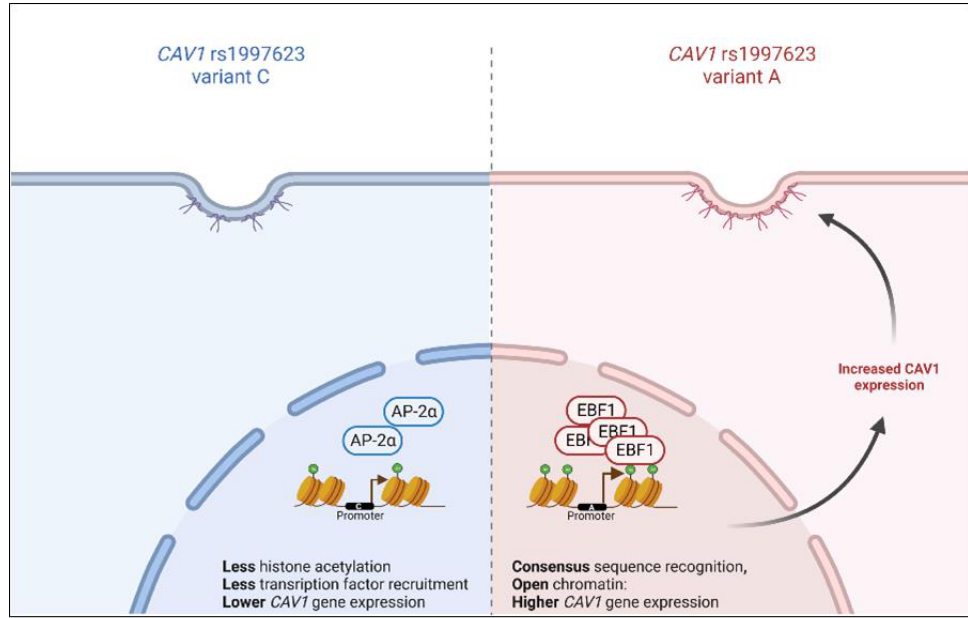
Figure 5. Mechanism of gene expression regulation by the CAV1 rs1997623 variant. The CAV1 rs1997623 allele-specific transcription factor binding increases histone acetylation and introduces differential transcription factor binding, leading to enhanced CAV1 gene expression. AP- 2α: acti- vating protein-2 alpha; EBF1: early B-cell factor 1. Created with BioRender.com (accessed on 1 Sep- tember